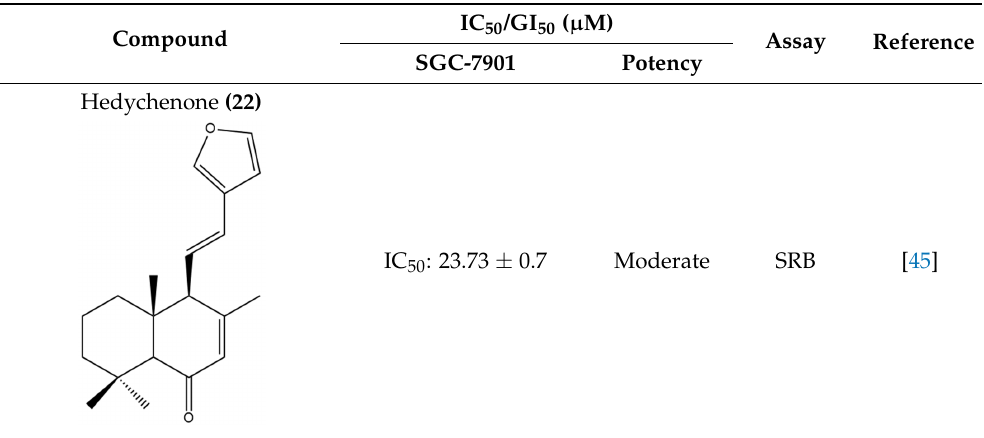
Table 9. Cytotoxic activities of labdane-type diterpenes from the Zingiberaceae against SGC-7901 cervical cancer cell line.